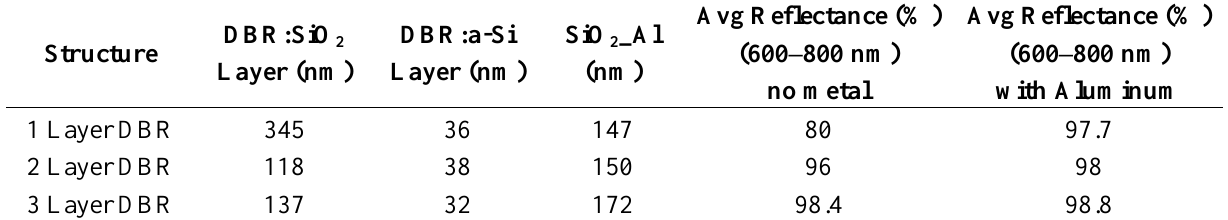
Table 1. The design parameters and performance characteristics of the 1, 2 and 3 layer DBR structures, are